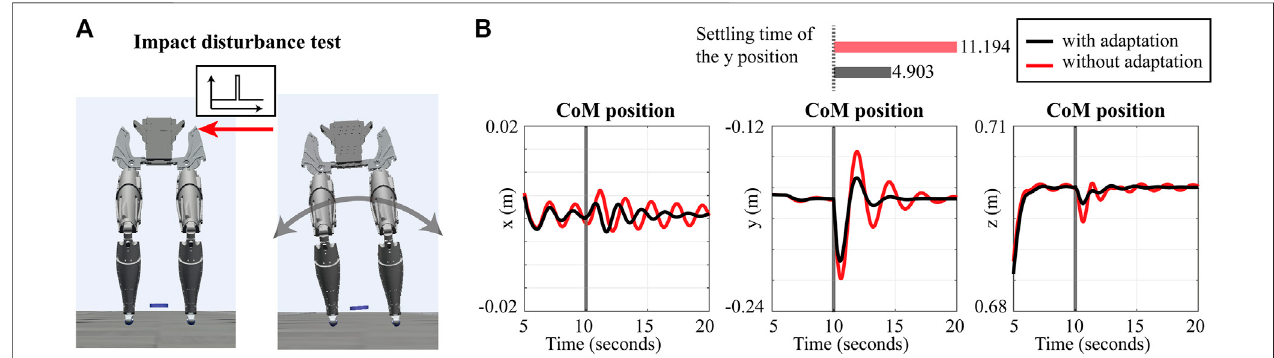
FIGURE6| Simulationresultsofimpacttest: (A) thedesiredpositionoftheCoMisthesameasthatforthepushingscenario.Animpactforceisappliedtotherobot with an amplitude of 700 N and duration 0.01 at 10 s. (B) The position of the robot ’ s CoM.